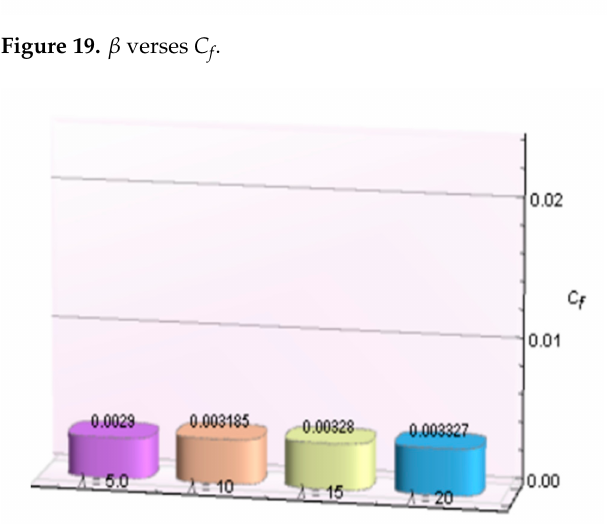
Figure 20. λ verses